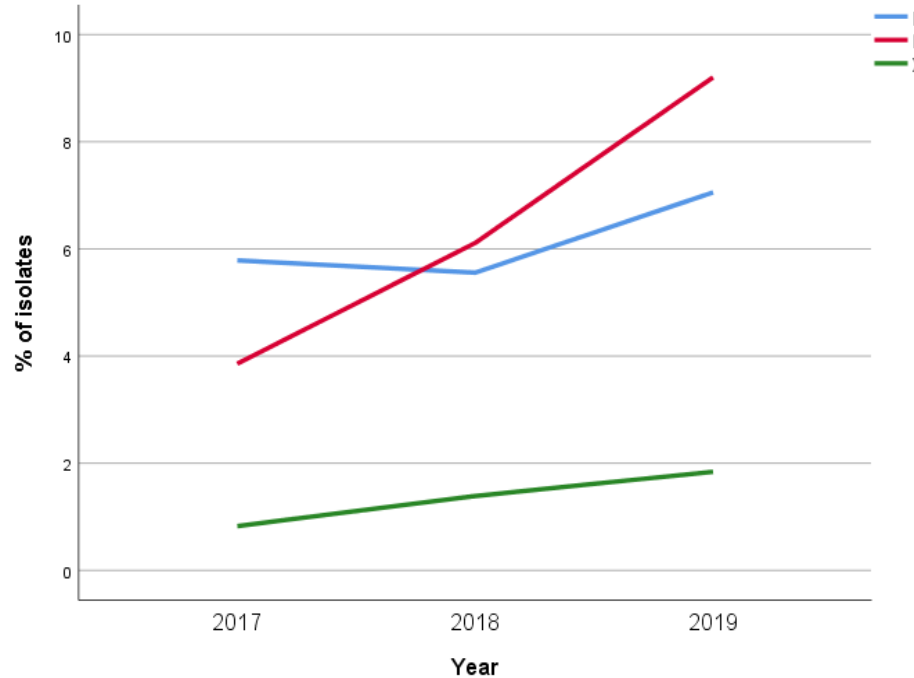
Figure 3. Annual prevalence of ESBL, MDR, and XDR E. coli in our study population.